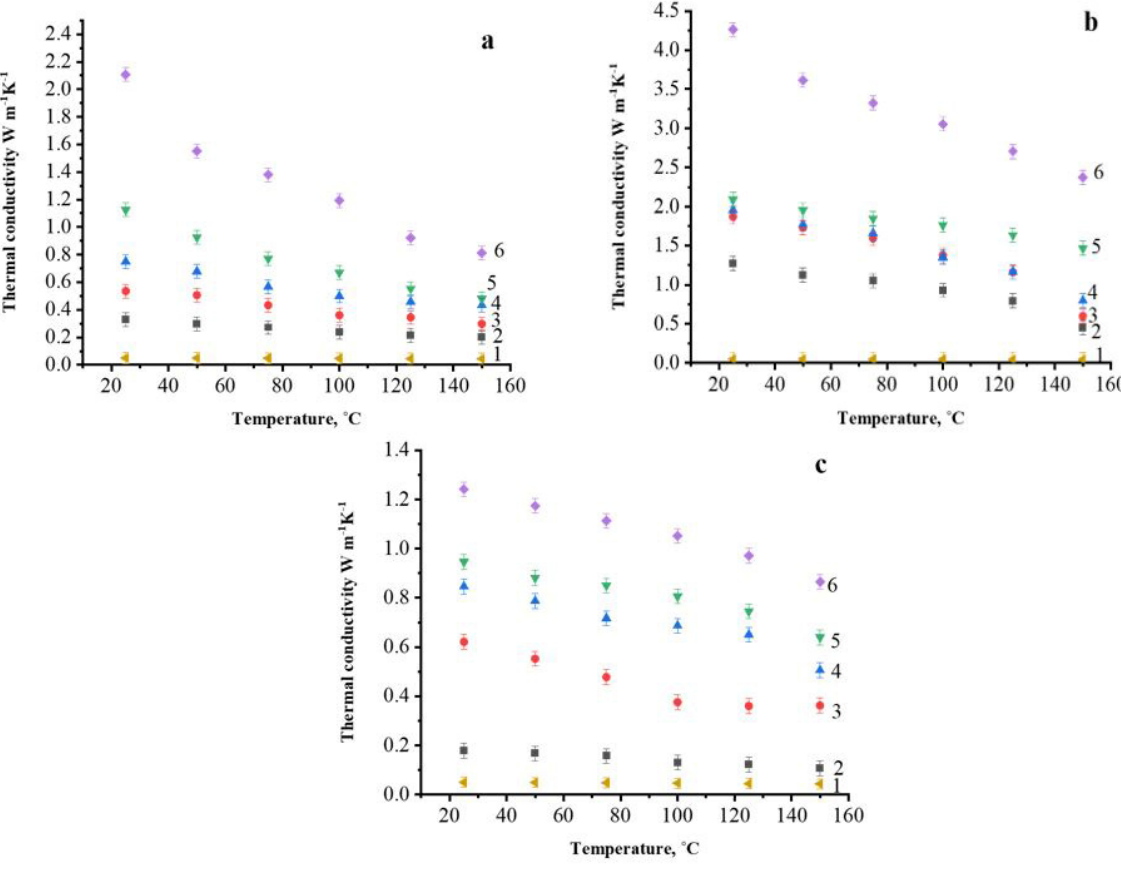
Figure 6. Thermal conductivity temperature dependences of PSU-based composites filled with 0 (1), 30 (2), 40 (3), 50 (4), 60 (5) and 70 (6) wt.% of AG ( a ), NG ( b ) and EG ( c ).